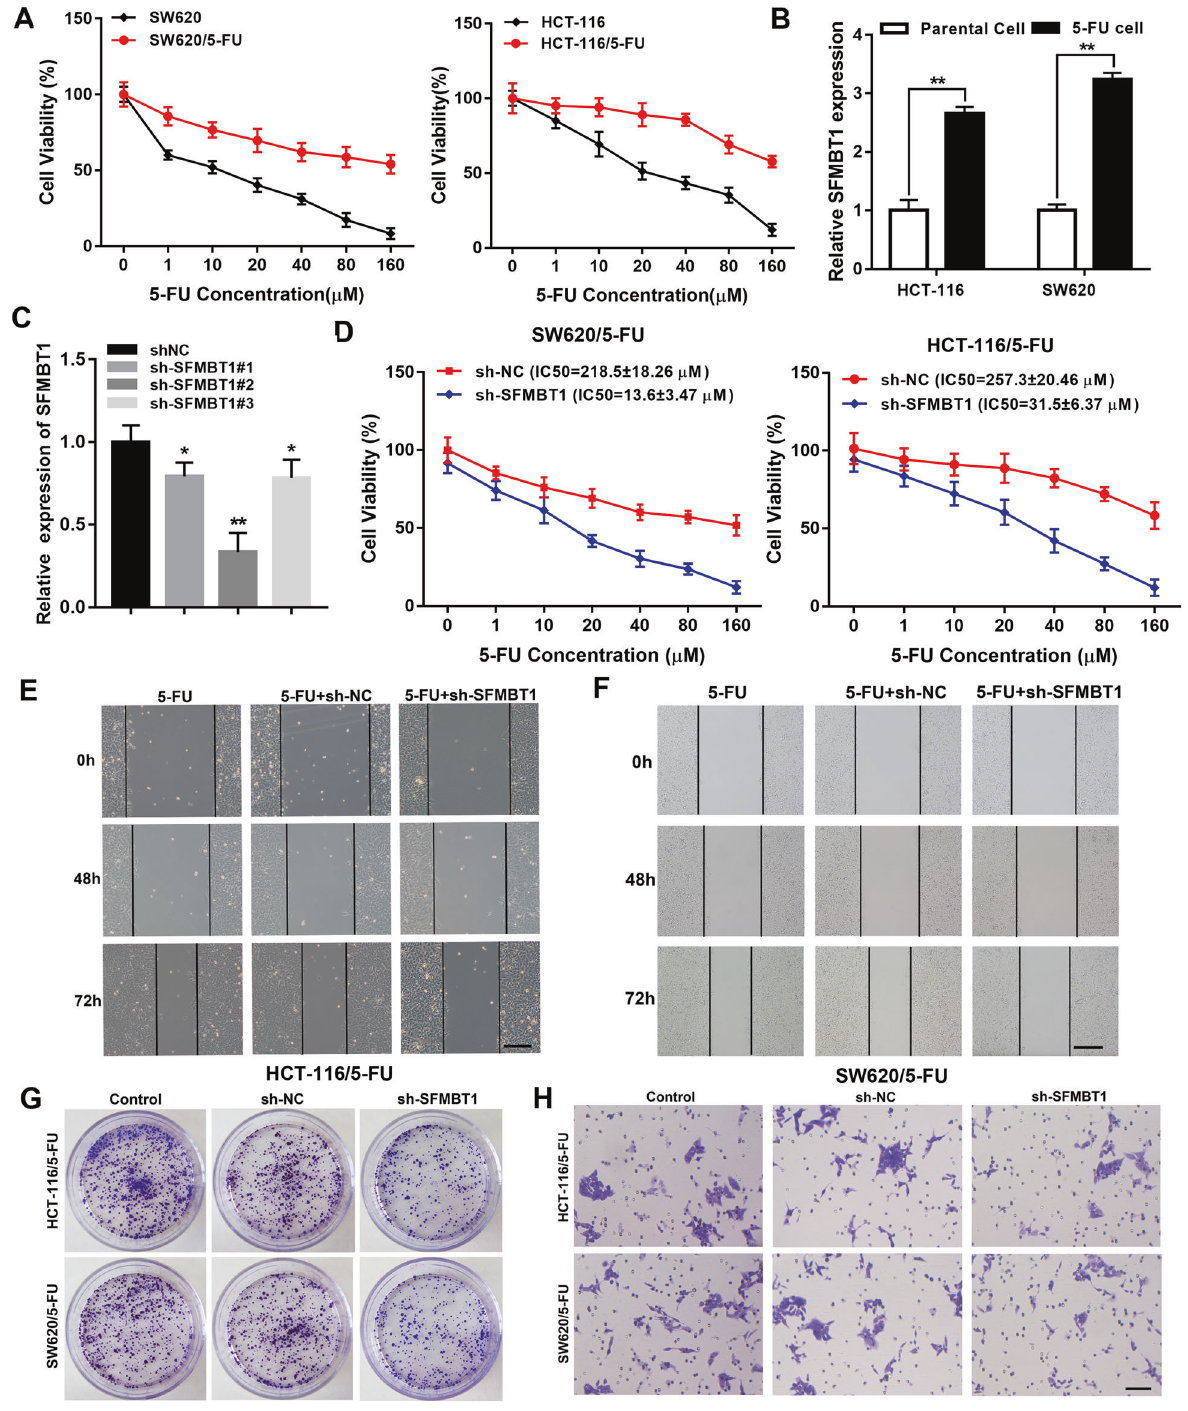
Fig. 2 SFMBT1 drives 5- fl uorouracil (5-FU) resistance and CRC proliferation, migration and invasion. A Cell viability with indicated concentrations of 5-FU was evaluated by MTT assay in parental and 5-FU resistance HCT-116 and SW620 cells. B SFMBT1 mRNA level in parental cells and 5-FU resistance cells. C Expression levels to determine the ef fi ciency of SFMBT1 knockdown by qRT-PCR. * P < 0.05, ** P < 0.01 . D Cell viability with indicated concentrations in HCT116/5-FU and SW620/5-FU after sh-NC or sh-SFMBT1 treatment by MTT assay. E , F Wound scratch assay to measure migration in HCT-116/5-FU ( E ) and SW620/5-FU ( F ) cells transfected with sh-NC or sh-SFMBT1. G Colony formation assay to measure proliferation in HCT-116/5-FU and SW620/5-FU cells transfected with sh-NC or sh-SFMBT1. H Transwell assay to measure invasion in HCT-116/5-FU and SW620/5-FU cells transfected with sh-NC or sh-SFMBT1.